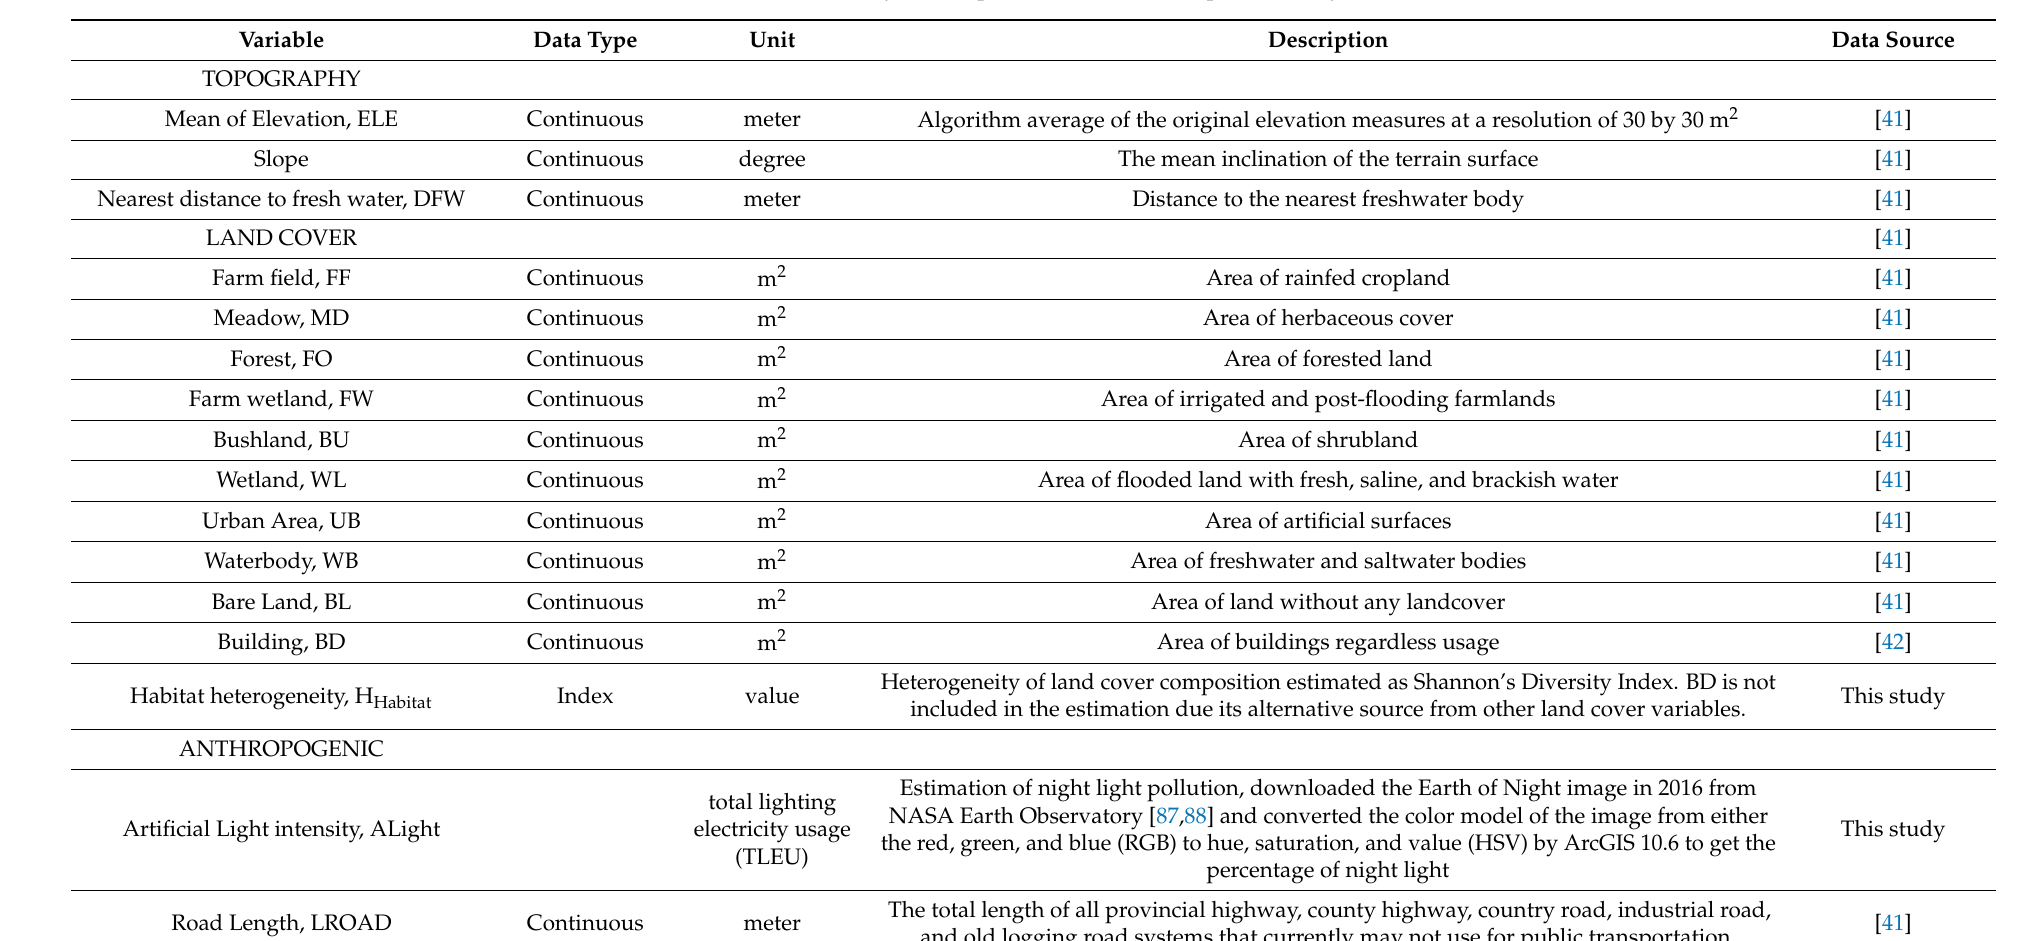
Table A1. Twenty landscape features used in the present